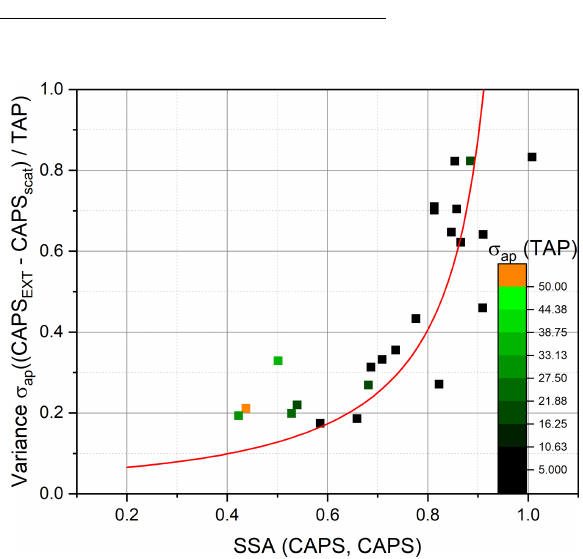
Figure 6. Variance of the measured absorption coefficients ( σ ap (CAPS, CAPS)/ σ ap (TAP)) for differential method calculations rel- ative to TAP measurements for AQ and AS external mixtures. The ratios are plotted against the aerosol measured SSA values (SSA(CAPS, CAPS)). The red line represents the calculated rela- tive errors using Gaussian error propagation of the uncertainties in the DM with 1 as